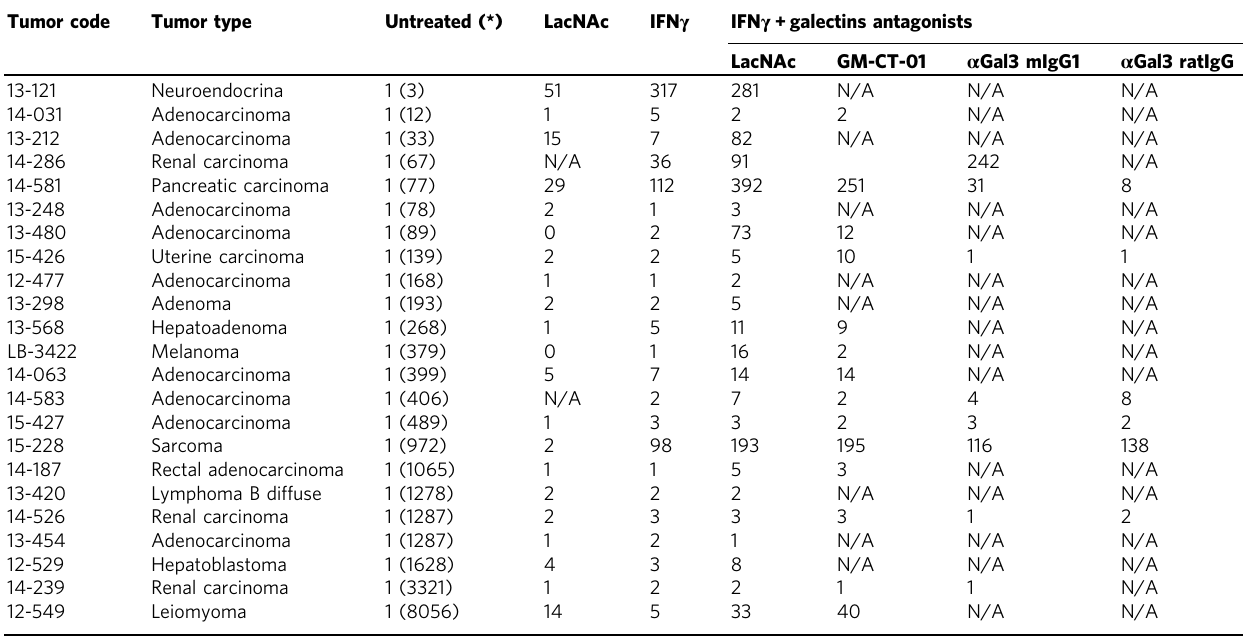
Table 1 CXCL9 expression in human tumor biopsies treated ex vivo with galectin antagonists. Tumor